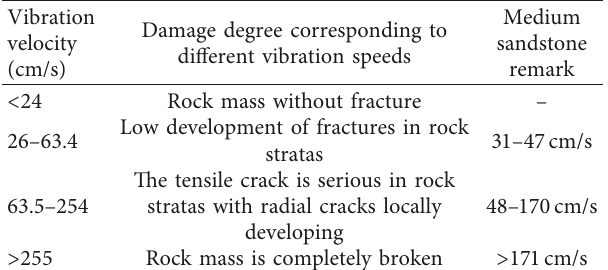
Figure 12: Evolution law of blasting-induced cracks (A: crushed zone; B: initial crack zone; C: the secondary fracturing length and interconnection zone induced by detonation gas). (a) 149.8 μ s, (b) 349.3 μ s, (c) 569.6 μ s, and (d) 749.6 μ s. Table 7: PPV critical